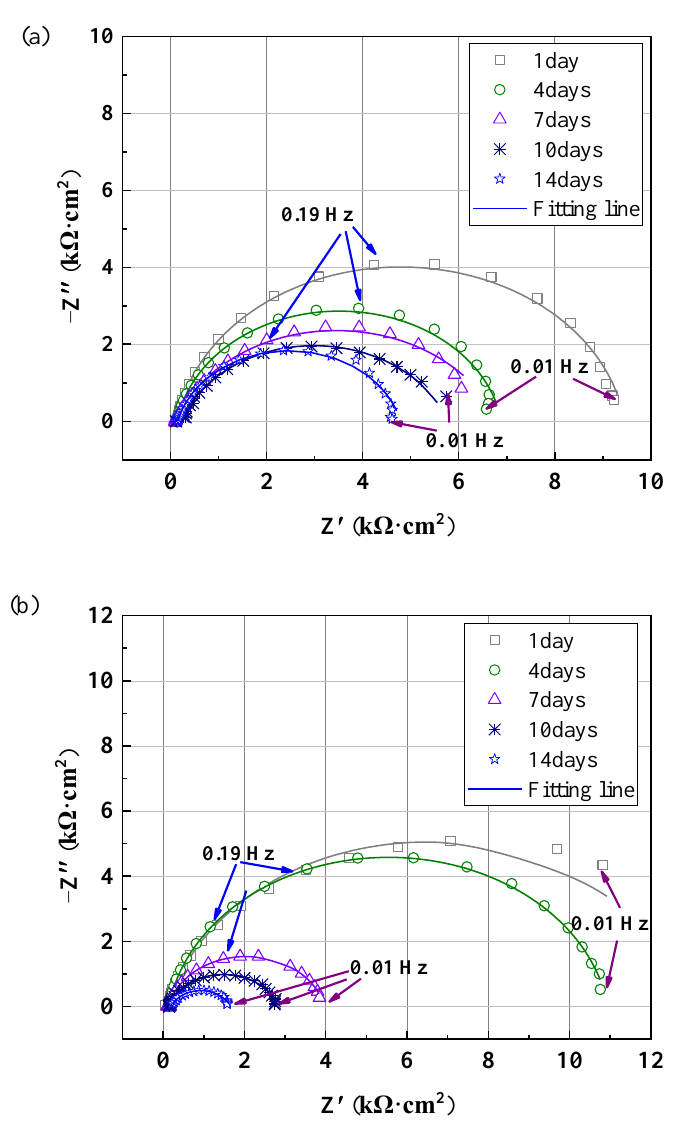
Figure 8. Nyquist plots of specimen in the abiotic ( a ) and SRB-inoculated soil solutions ( b ). An electrical equivalent circuit (EEC) (Figure 9), i.e., R s ( Q dl R ct ), was used to analyze